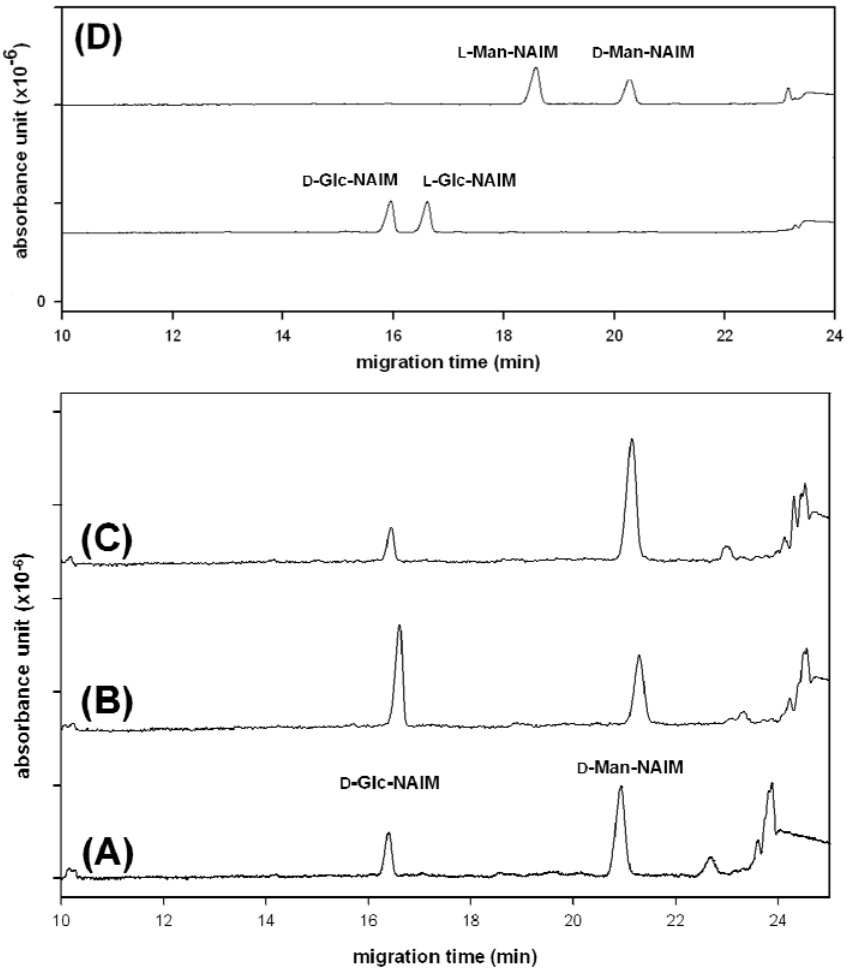
Figure 2. CE analysis of the monosaccharide components (as the NAIM derivatives) in D. huoshanense (DH) polysaccharide. ( A ) the hydrolysate of DH polysaccharide with NAIM tag; ( B ) the hydrolysate with D -Glc-NAIM spiked; ( C ) the hydrolysate with D -Man-NAIM spiked; and ( D ) resolution of enantiomeric pairs of Glc-NAIM and Man-NAIM. The NAIM derivatives of incomplete hydrolytic oligosaccharides appeared after 22 min. CE conditions: phosphate buffer (300 mM, pH 3.0), sulfated- α -CD (10 mg/mL) as the chiral selector, applied voltage of 15 kV (detector at cathode side), uncoated fused-silica capillary of 30 cm (effective length) × 50 μ m id, sample (0.2 µmol) loaded by pressure for 5 s, operation temperature at 30 °C, and detection wavelength at 254